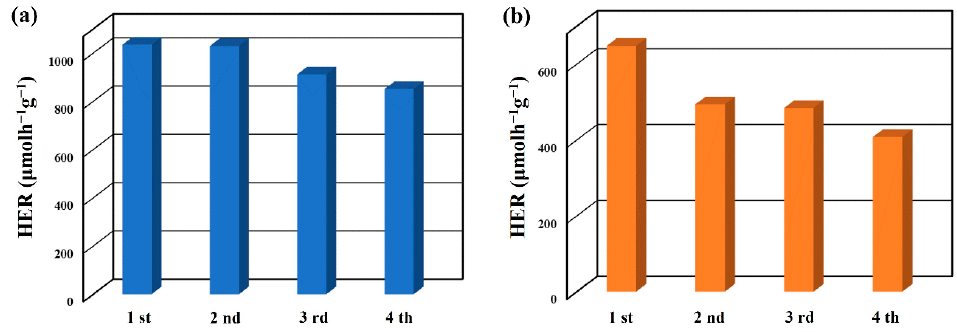
Figure 8. The cycling stability of the optimized Cu 2 O/CuS/ZnS nanocomposite under ( a ) blue LED light and ( b ) white LED light